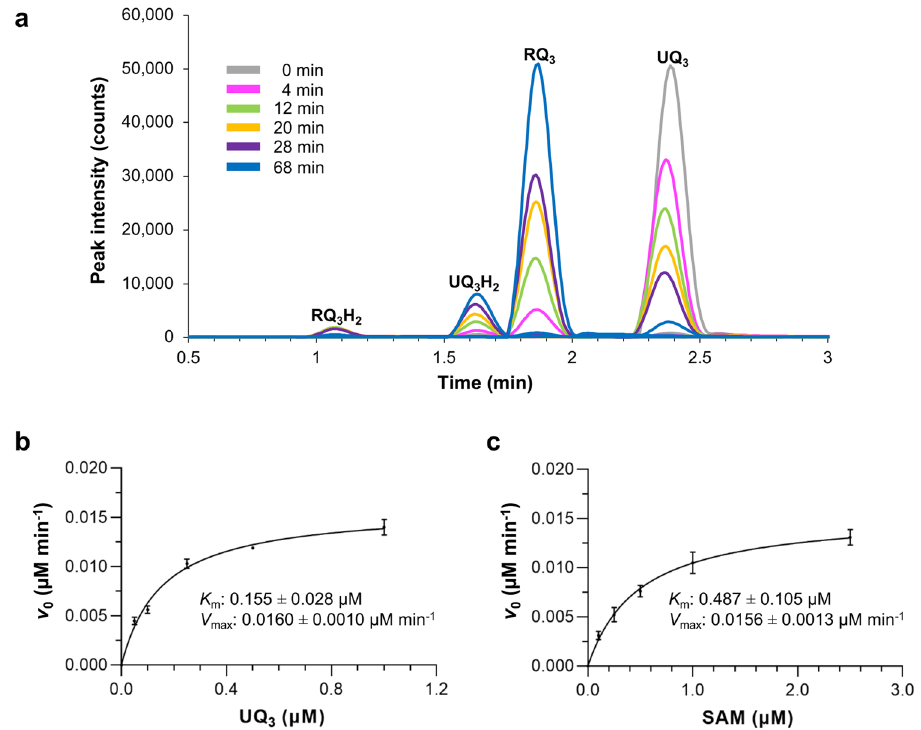
Fig. 2 RquA kinetic study. a Time course chromatograms measuring the production of rhodoquinone-3 (RQ 3 ) are overlaid for an MBP-RquA in vitro assay monitored by liquid chromatography-mass spectrometry (gray: 0 min, magenta: 4 min, green: 12 min, orange: 20 min, purple: 28 min, blue: 68 min) after ubiquinone-3 (UQ 3 ) (1 μ M) was added to MBP-RquA (0.5 μ M) with S -adenosyl- L -methionine (SAM, 5 μ M). b A Michaelis – Menten curve was generated for varying UQ 3 concentrations (0.05 – 1 µ M) at 0, 4, 8, and 16 min time points with MBP-RquA (0.5 μ M) and SAM (5 μ M). c A second Michaelis – Menten curve was generated for varying SAM concentrations (0.1 – 2.5 µ M) at the same time points with MBP-RquA (0.5 μ M) and UQ 3 (5 μ M). The V max corresponds to a peak speci fi c activity of 0.22 pmol min − 1 μ g protein − 1 . For b , c , n = 3 independent experiments and error bars represent the standard deviation of the